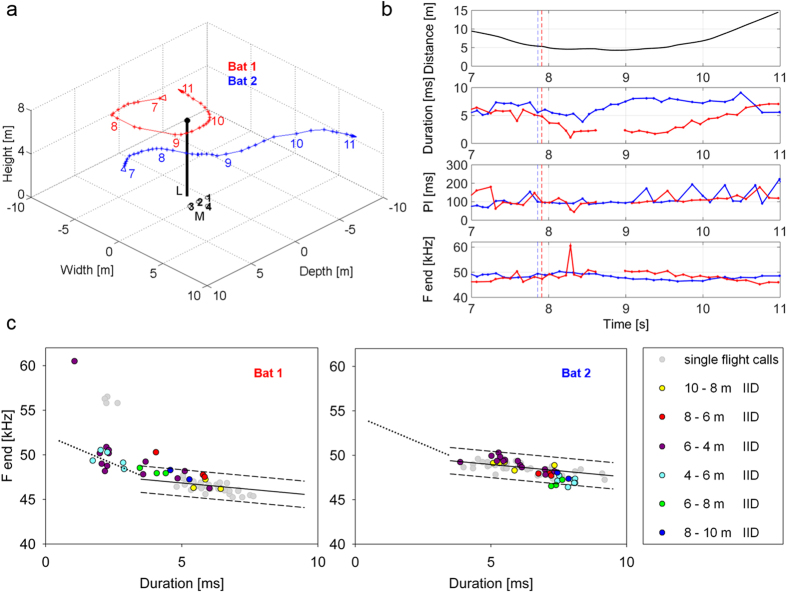
(a) 3D plot of the flight paths where Bat 1 pursued Bat 2. Open arrows indicate the start and filled arrows the end of the flight path. Time (in seconds) is marked by numbers. L = street light, M = microphone array. (b) Inter-individual distance and call parameters of Bat 1 (red) and Bat 2 (blue). The dotted vertical lines mark the beginning of the bats’ reaction in echolocation behavior. (c) Correlation of terminal frequency with call duration of Bat 1 and Bat 2 from signals emitted in single flight (grey dots) and in flight with the conspecific (colored dots). The single flight signals were used to position the individual transmission channels (between dashed lines) at the 5.5 ms frequency values. The color of the dots indicates groups of inter-individual distances (IID). The pursuing Bat 1 reacted at a distance of 5.3 m with a distinct reduction of pulse duration and interval which continued up to t = 10.5 s, after both bats had turned away from one another. At about the same distance, the pursued Bat 2 reacted with a minor reduction of pulse duration which ended at t = 8.5 s, when it was ahead of Bat 1. During the flight with the conspecific, the frequency of nearly all signals of Bat 1 and Bat 2 were within the transmission channels. The few signals outside the transmission channels even reduced the frequency difference between Bat 1 and Bat 2. Bat 1 also emitted one short, high frequency call while reacting to Bat 2.